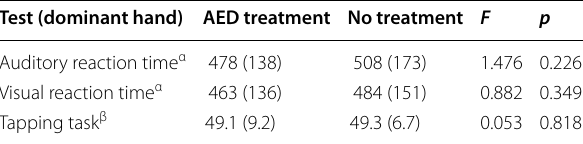
α—lower values indicate better performance; β—higher values indicate better